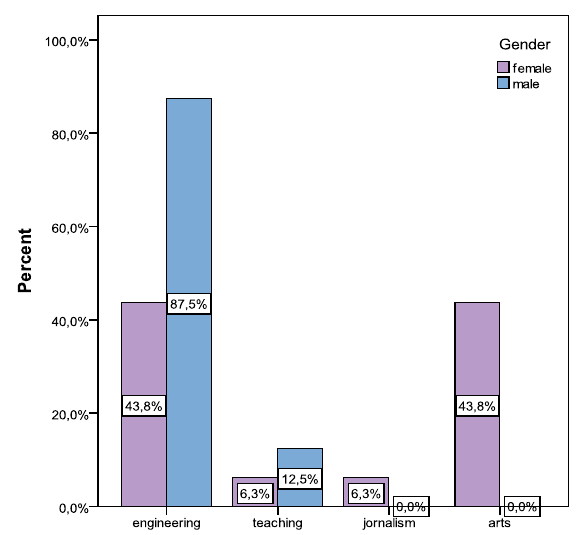
Figure 8. K-12 students’ answer to the question “Which course, at this moment, you would like to